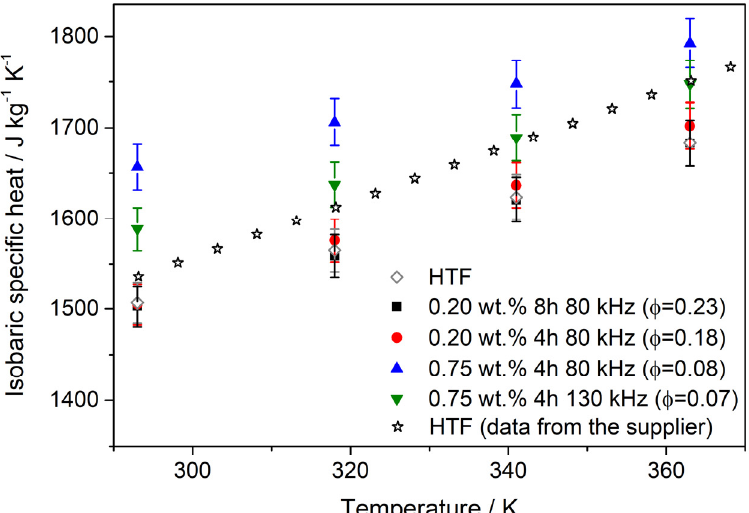
Figure 6. Isobaric specific heat values for nanofluids and pure HTF. The values for pure HTF from the supplier are included for comparison purposes.